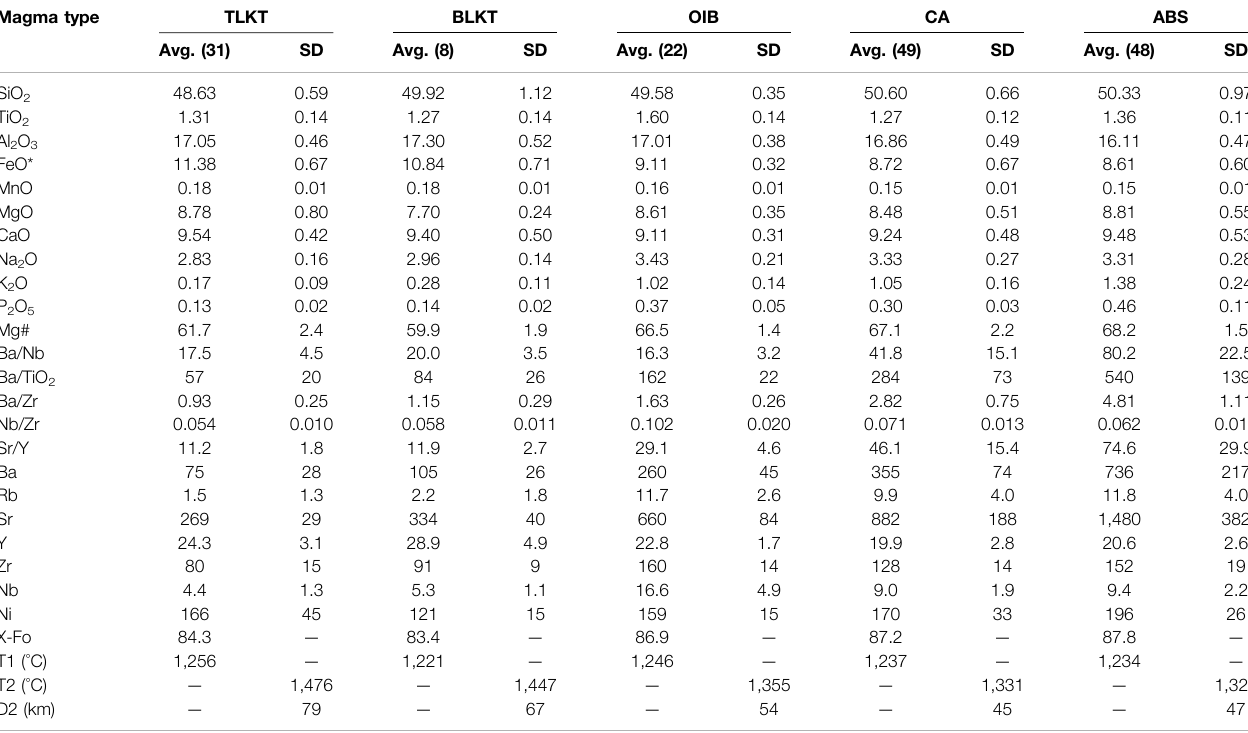
TABLE 1 | Averages ± SD for BVF primitive basaltic magma types. Magma